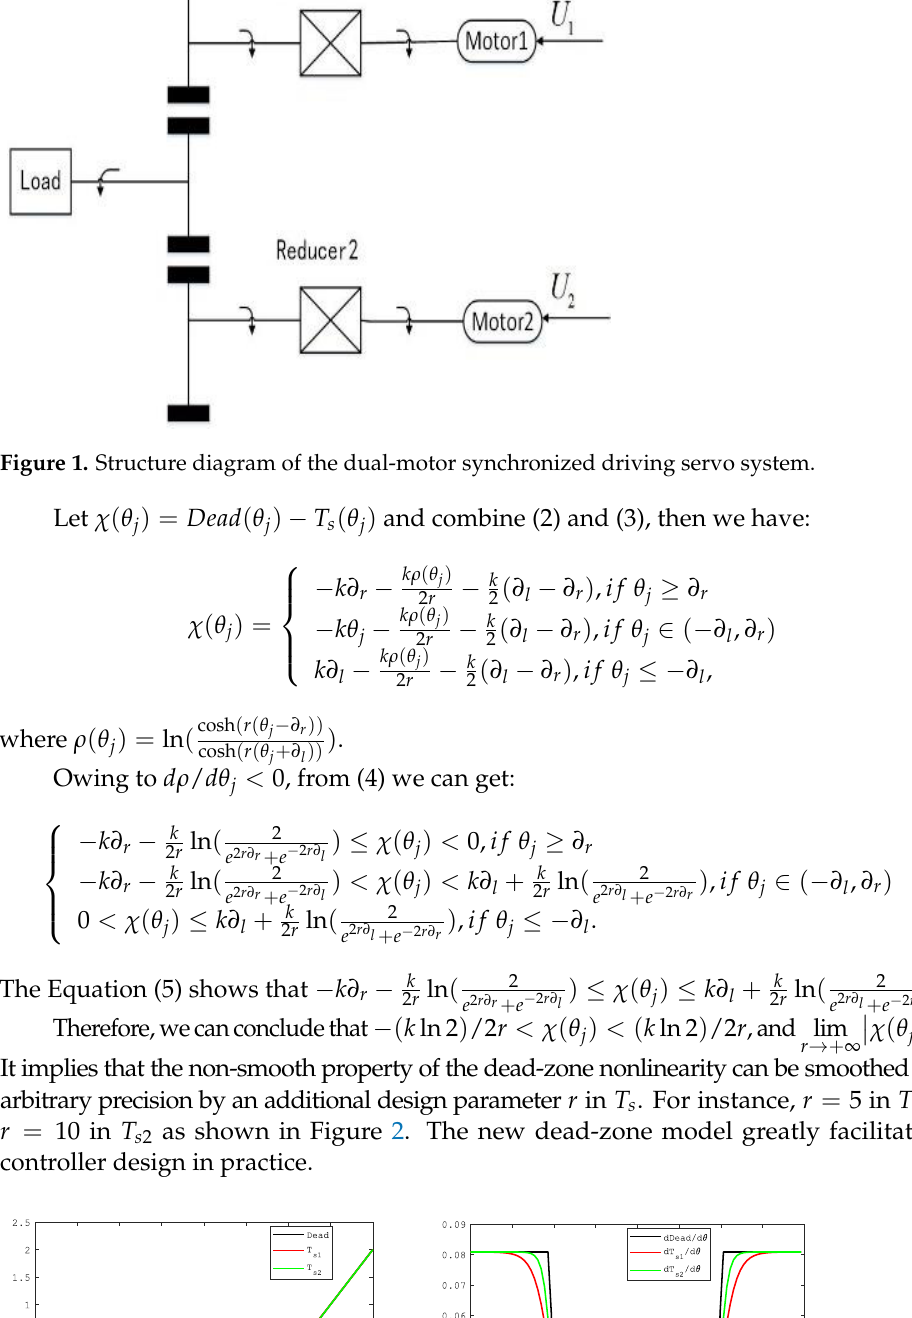
Figure 2. Dead-zone approximation: 2, 1.5, 0.5